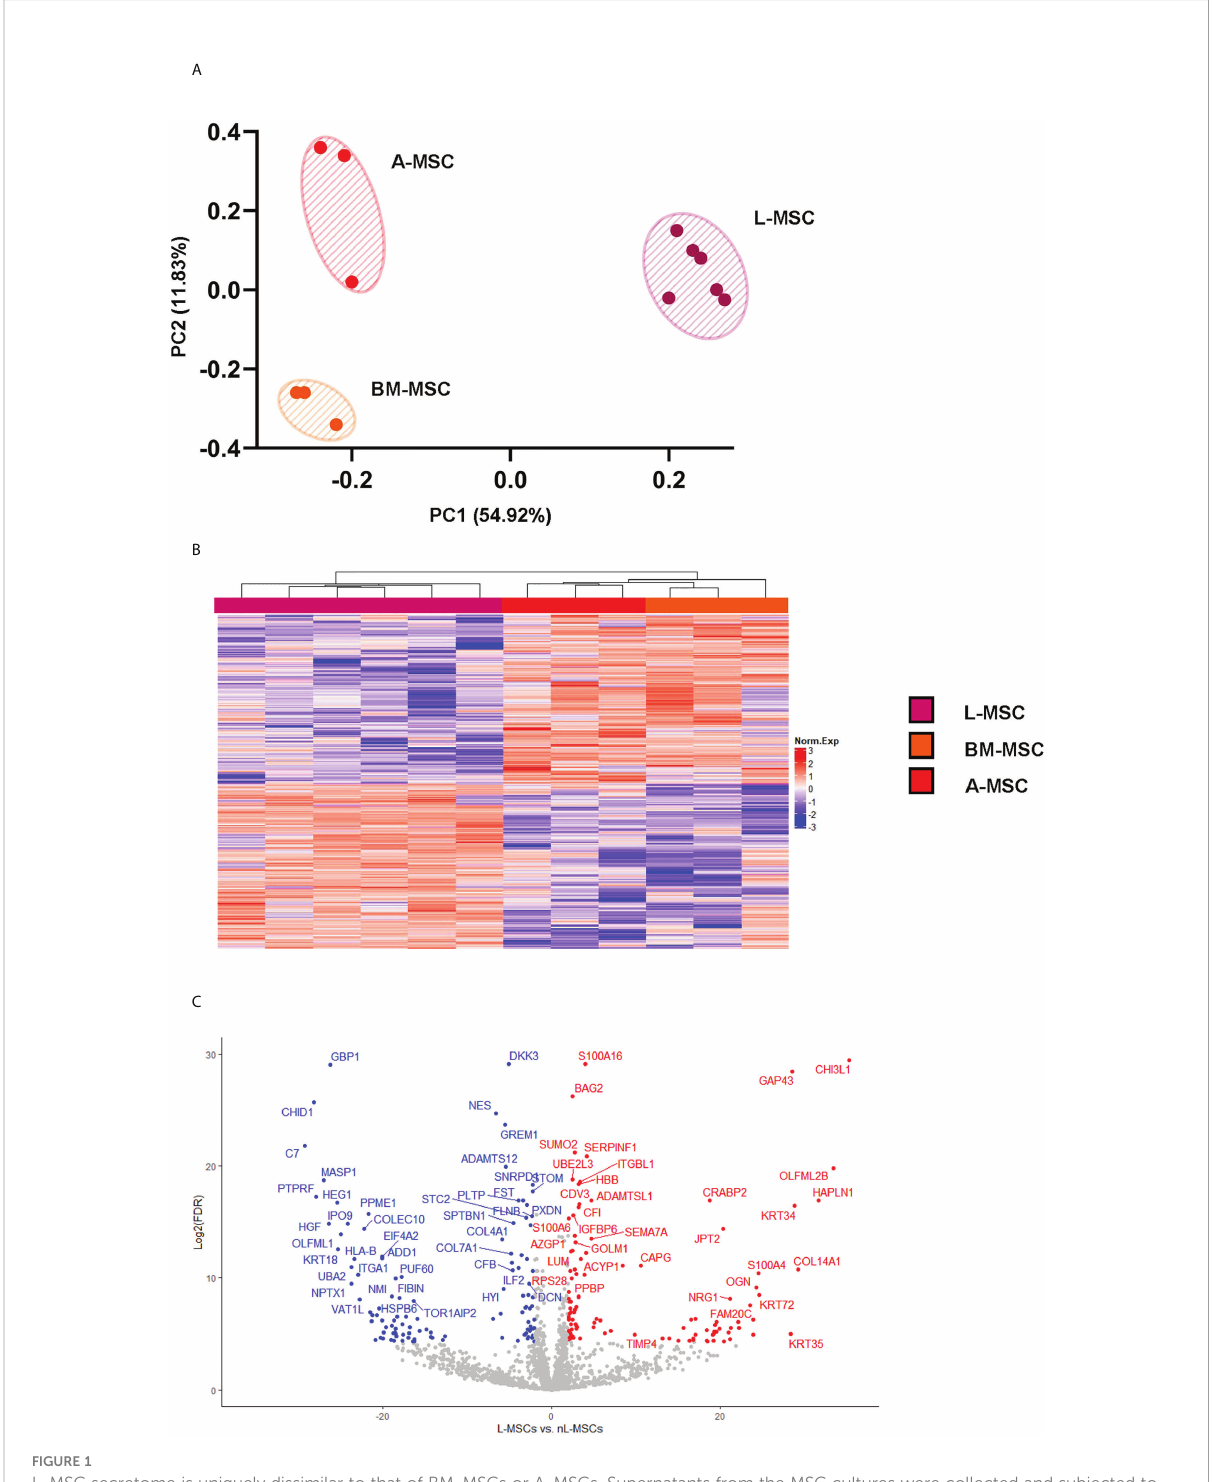
FIGURE 1 L-MSC secretome is uniquely dissimilar to that of BM-MSCs or A-MSCs. Supernatants from the MSC cultures were collected and subjected to proteomic analysis. (A) The PCA demonstrates that the MSC secretomes from different sources cluster together, with intragroup homogenicity and intergroup heterogenicity. (B) The heatmap shows that the L-MSC secretome is signi fi cantly different that the secretomes of BM-MSC and A-MSC. (C) The volcano plot demonstrates the relationship between the magnitude of protein expression change (log2 of fold-change; x-axis) and statistical signi fi cance of this change compared to L-MSCs and nL-MSCs. L-MSC, liver mesenchymal stromal cell; BM-MSC, bone marrow mesenchymal stromal cell; A-MSC, adipose mesenchymal stromal cell; nL-MSC, non-liver